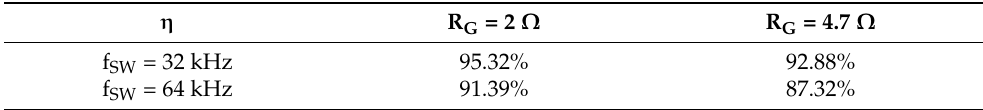
Table 5. Outcome of the parametric analysis conducted on the inverter: efficiency ( η ) evaluated at different R G and f SW